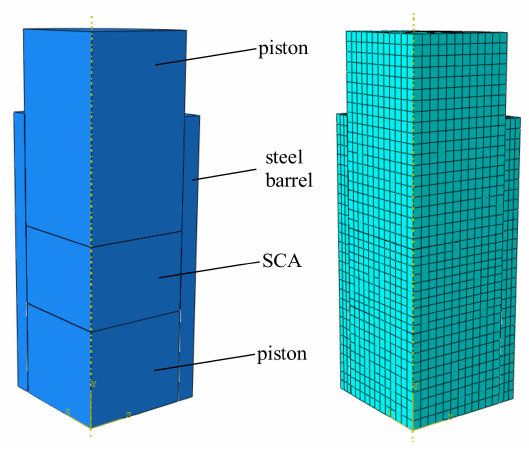
Figure 3. The finite element model.